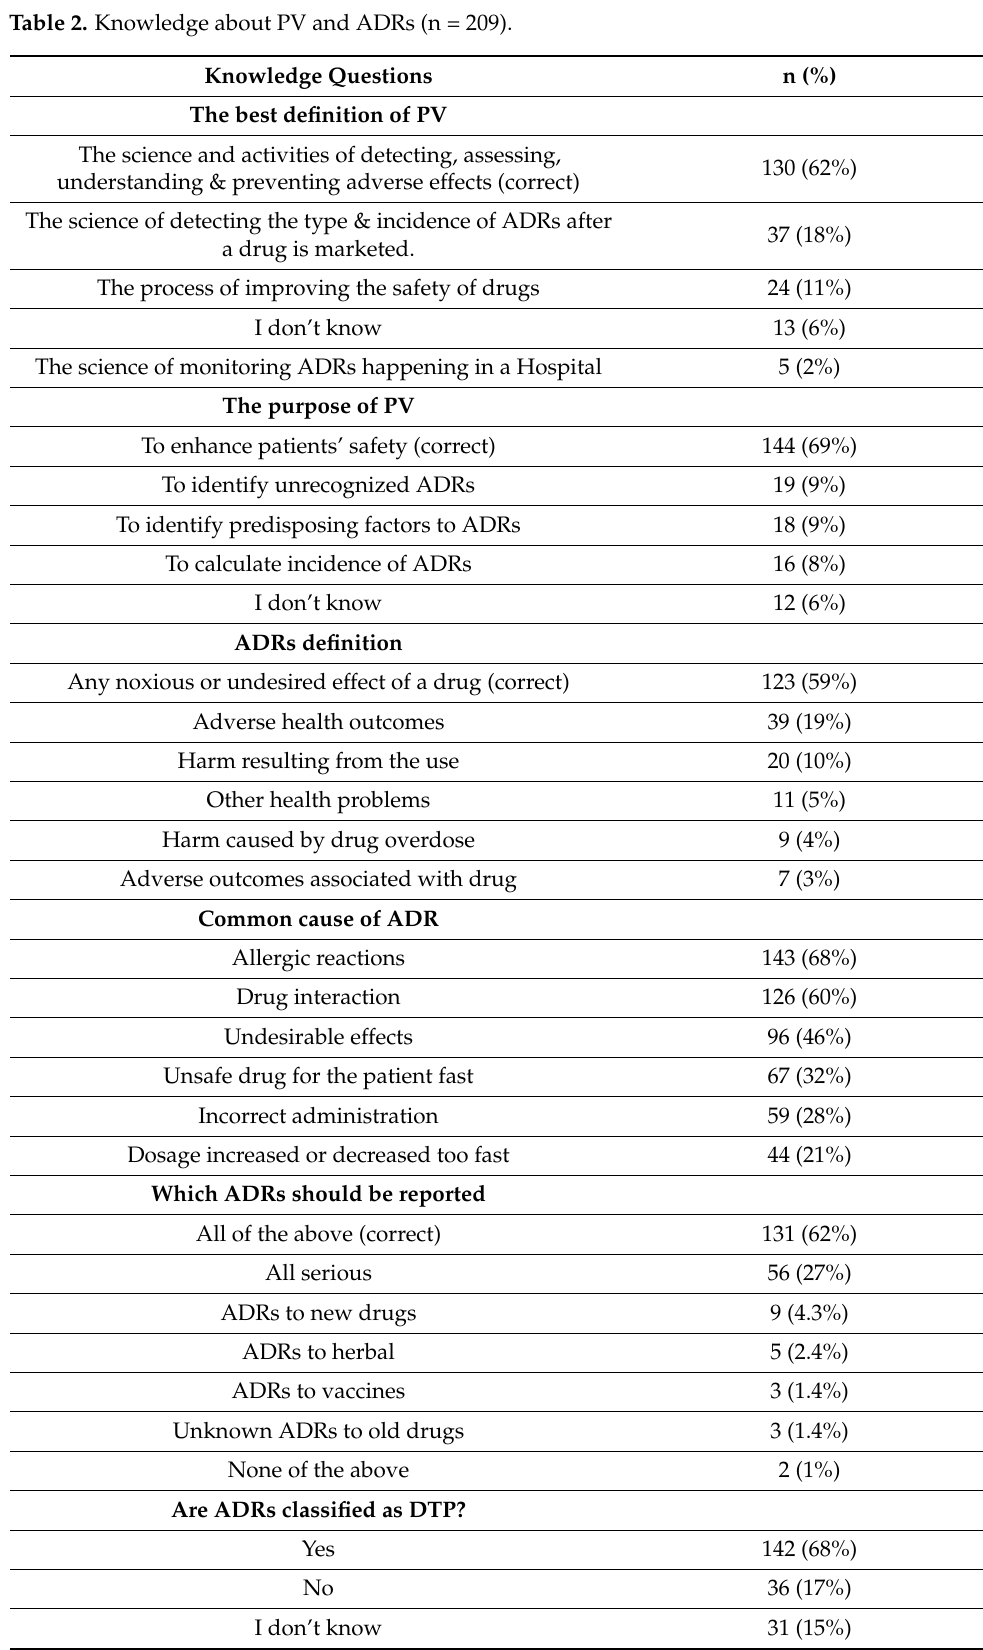
Table 2. Knowledge about PV and ADRs (n =